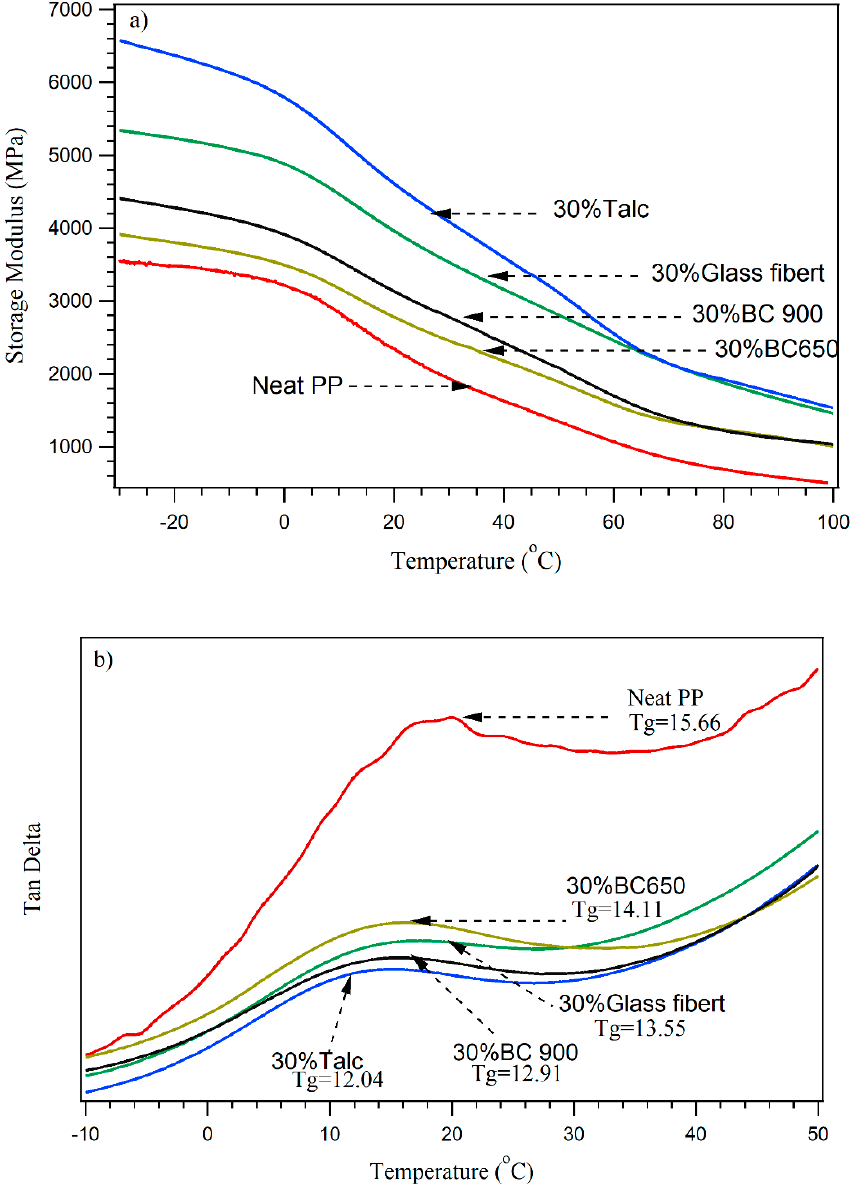
Figure 8. ( a ) Storage modulus and ( b ) tan δ of neat PP and PP-filler composites.